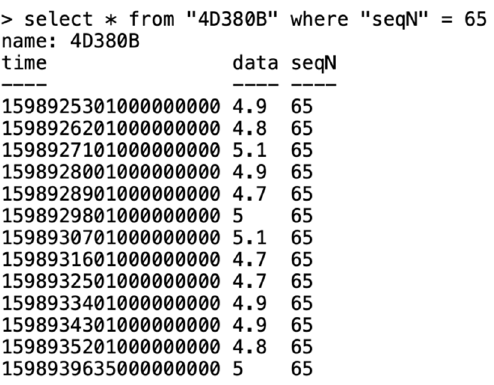
Figure 12. Example of a Sigfox message in the InfluxDB database.